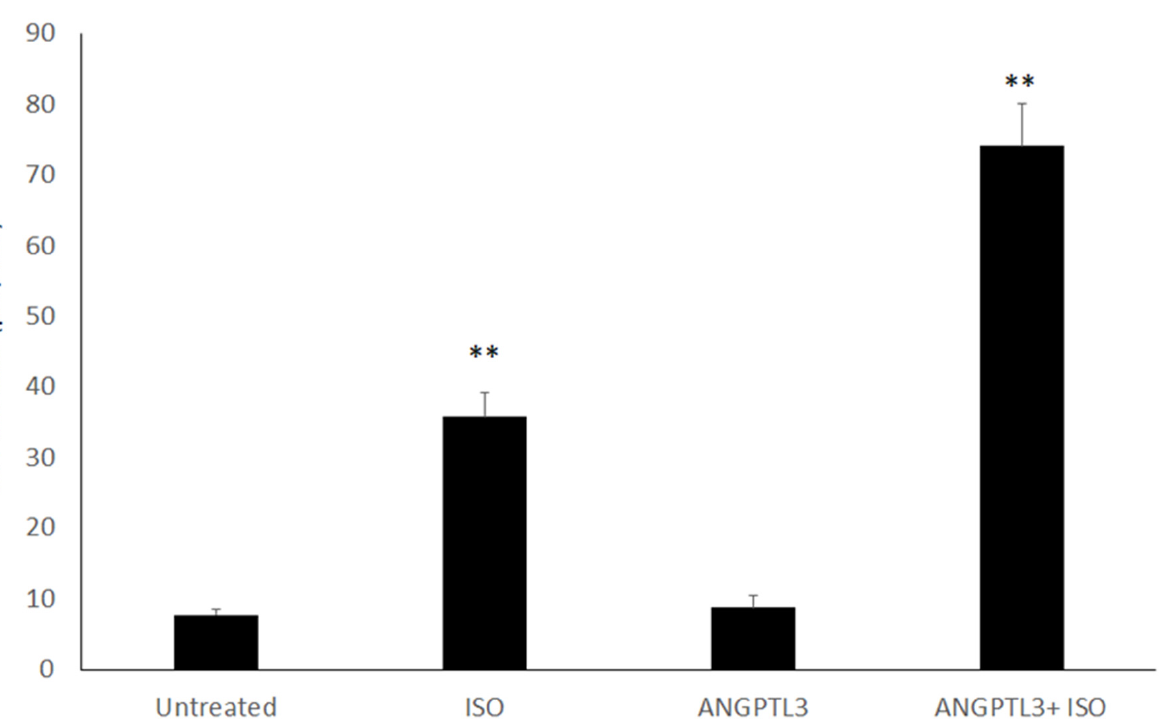
Figure 1. ANGPTL3 pretreatment promotes lipolytic effects in adipocytes. Free fatty acid (FFA) concentration increase ( µ M/min) in 3T3-L1 cell line treated for 30 and 60 min with ISO, recombinant human ANGPTL3, or pretreated for 10 min with ANGPTL3, and treated for 30 and 60 min with ISO (ANGPTL3 + Iso). The samples were compared with 3T3-L1 untreated cells. Data were expressed as mean ± SD of three biological replicates of the experiment. p value: ** < 0.001 ( t